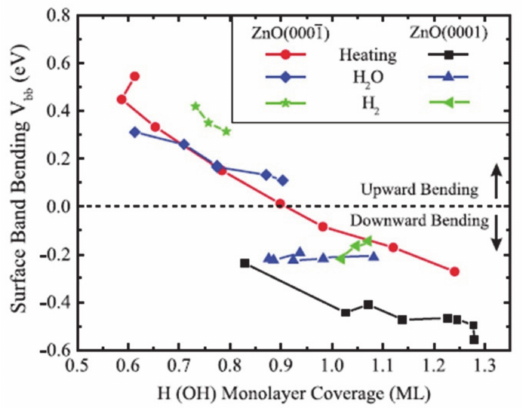
Figure 3. The surface termination of the ZnO changes the band bending at the surface, which is observed by the X-ray photoelectron spectroscopy. The figure is reproduced from Ref. [46] with permission from the American Physical